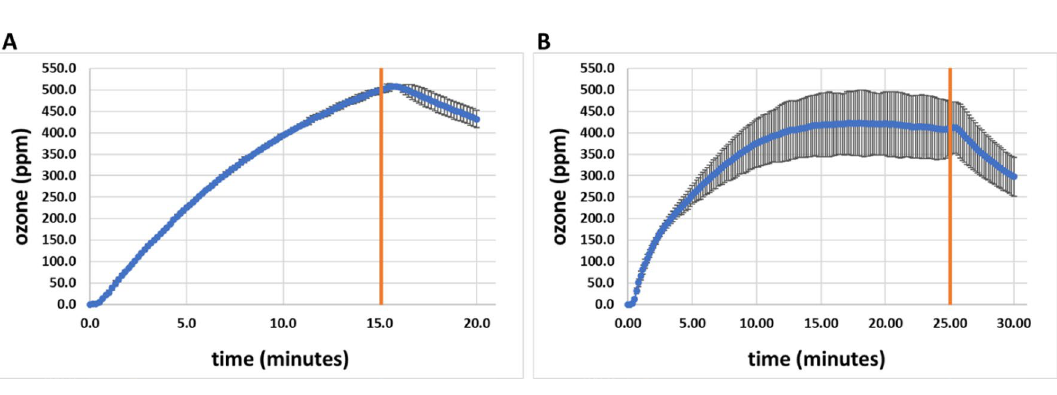
Figure 13. APS ozone data for ( A ) 4 CPPRs and 20 min exposure (15 min CPPRs on—depicted by orange line, 5 min CPPRs off) and ( B ) 6 CPPRs and 30 min exposure (25 min CPPRs on—depicted by orange line, 5 min CPPRs